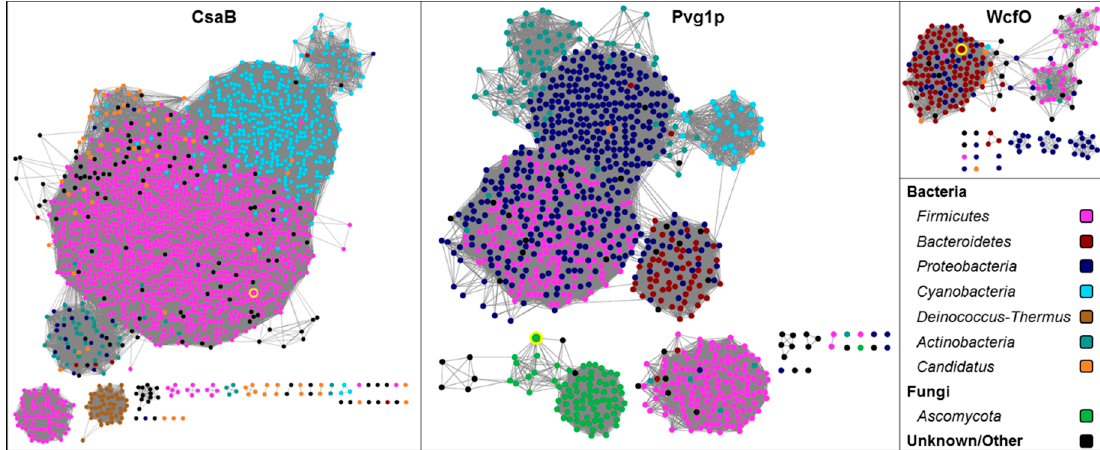
Figure 6. Sequence similarity networks illustrating the extant sequence space around Paenibacillus alvei CsaB (K4ZGN3), Schizosaccharomyces pombe Pvg1p (Q9UT27), and Bacteroides fragilis WcfO (Q5LFK7). The three characterized sequences—CsaB, Pvg1p, and WcfO—are highlighted by yellow circles.